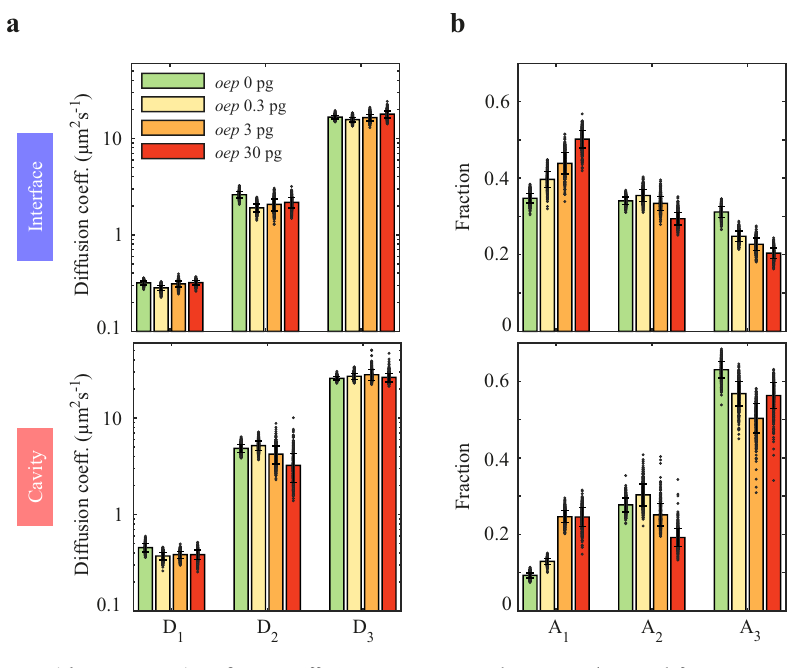
Fig. 5 | Mobility of Squint decreases with overexpression of oep. a Diffusion coef fi cientsand ( b )fractionsofthethree-componentdiffusionmodelininterfaces and cavities for Squint at different amounts of mRNA encoding Oep. Data are